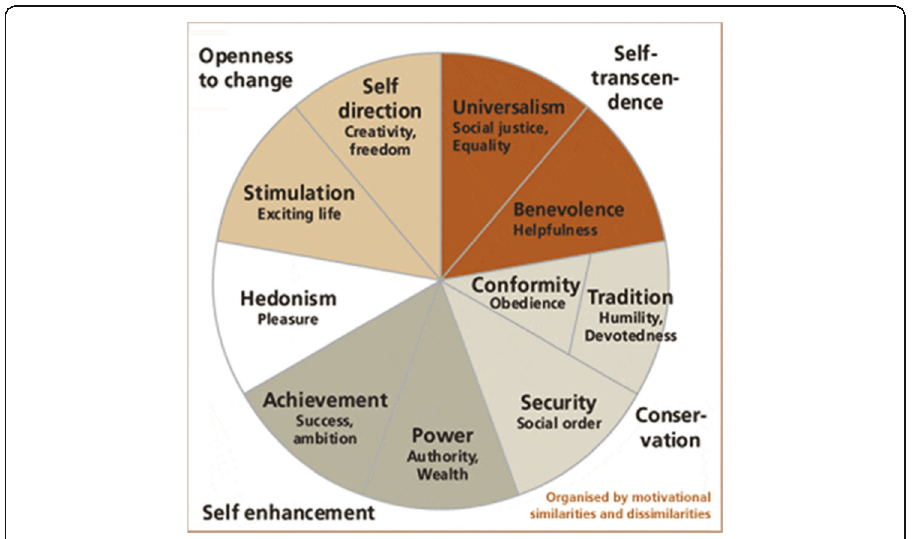
Fig. 2 Theoretical model of relations among ten motivational